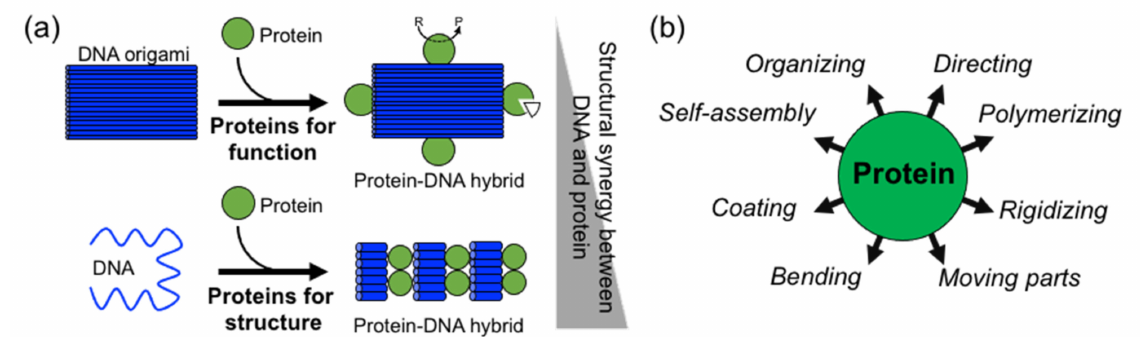
Figure 1. Overview of structural protein–DNA nanotechnology. ( a ) “Proteins for function” versus “proteins for structure” in DNA nanotechnology. In the latter case, there is much more synergy between the protein and the DNA building blocks. “R” means reactive and “P” product. ( b ) Structural roles of proteins in hybrid protein–DNA